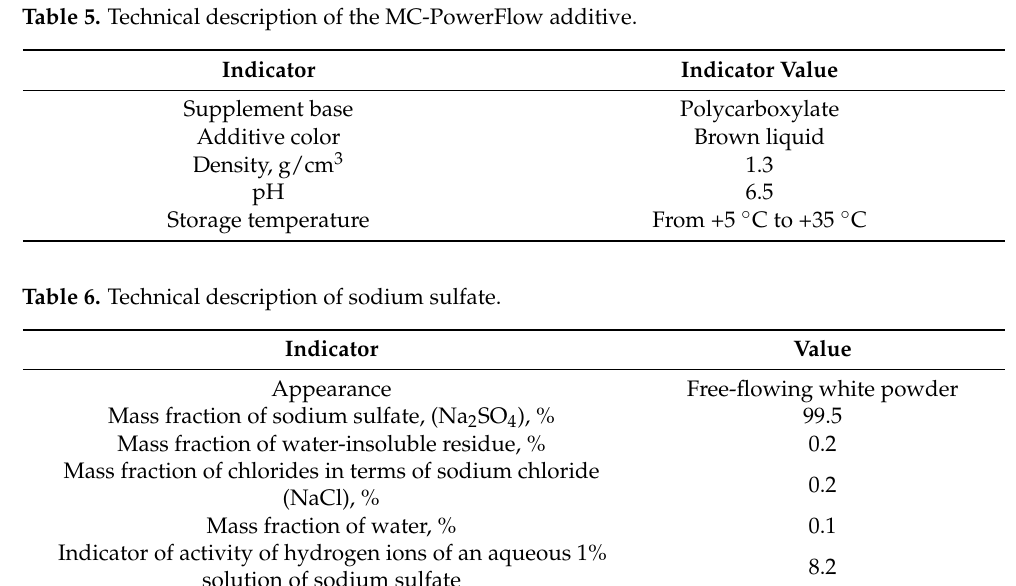
Table 5. Technical description of the MC-PowerFlow additive.